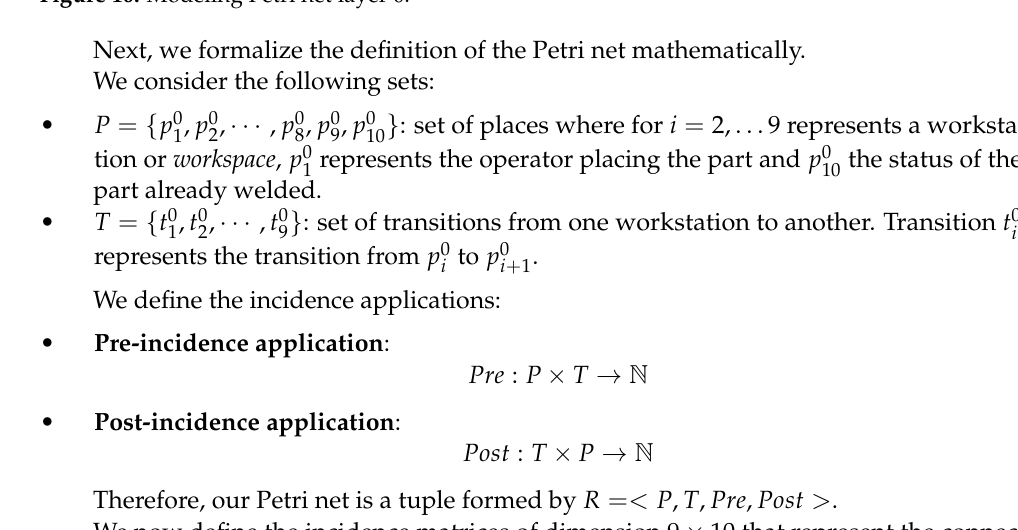
Figure 10. Modeling Petri net layer